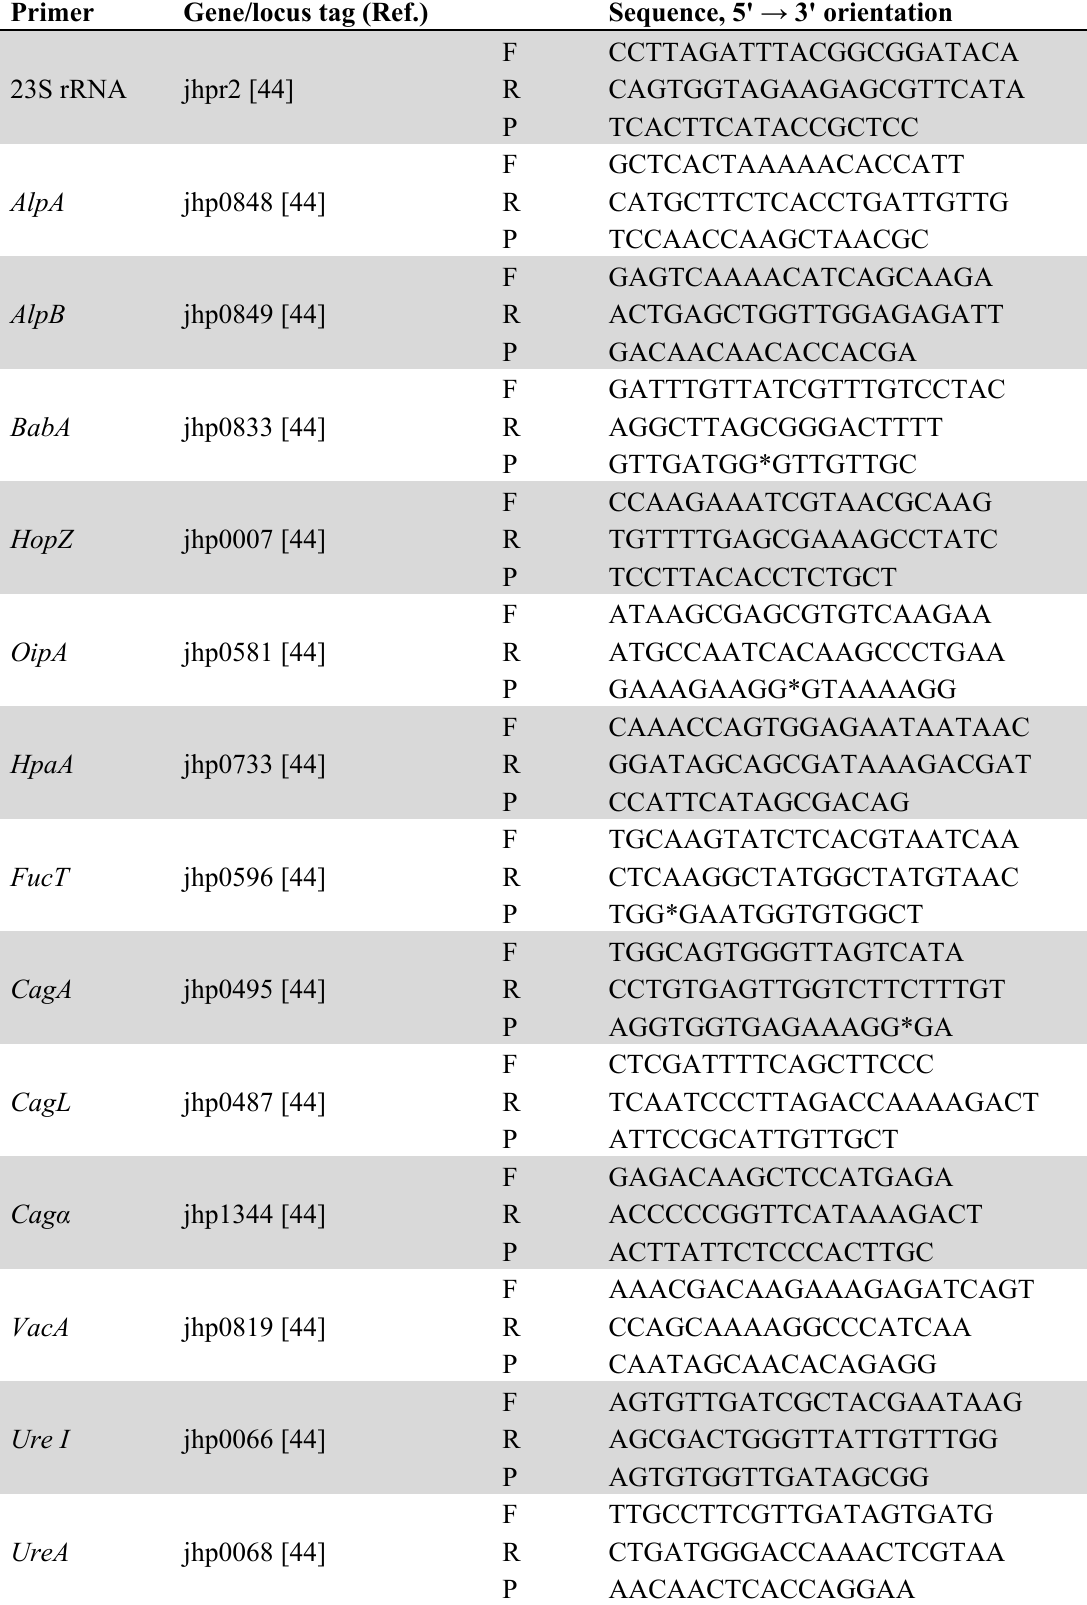
Table 2. Primer sequences for H.pylori (Qiagen). F = Forward Primer; R = Reverse Primer, P = QuantiProbe (label = FAM); * = modified